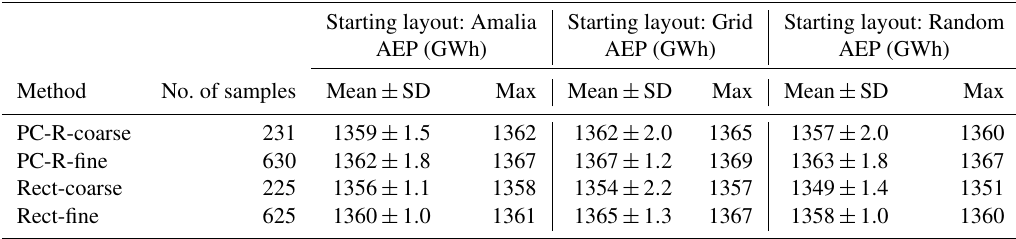
Table 2. The AEP of the optimized layouts. We generate the AEP statistics for each method from a set of 10 different optimizations. For a similar number of samples, both coarse and fine, polynomial chaos based on regression produces better optimal layouts than the rectangle rule. Furthermore, using about one-third of the samples, PC-R optima are comparable with the optima obtained with the rectangle rule that used 625 samples to compute the AEP. The values of the AEP reported are computed with 200000 Monte Carlo samples. Starting layout: Amalia Starting layout: Grid Starting layout: Random AEP (GWh) AEP (GWh) AEP (GWh)